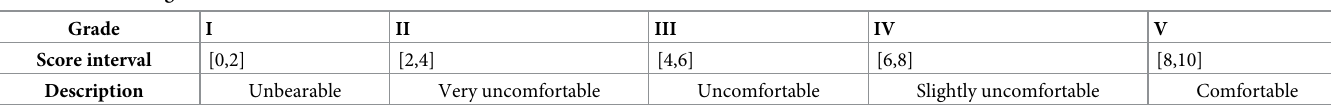
Table 1. Evaluation grade of comfort.